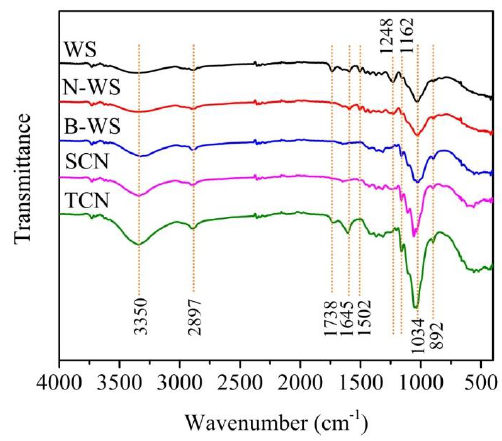
Figure 4. FTIR spectra of WS, N-WS, B-WS, TNC, and SNC.